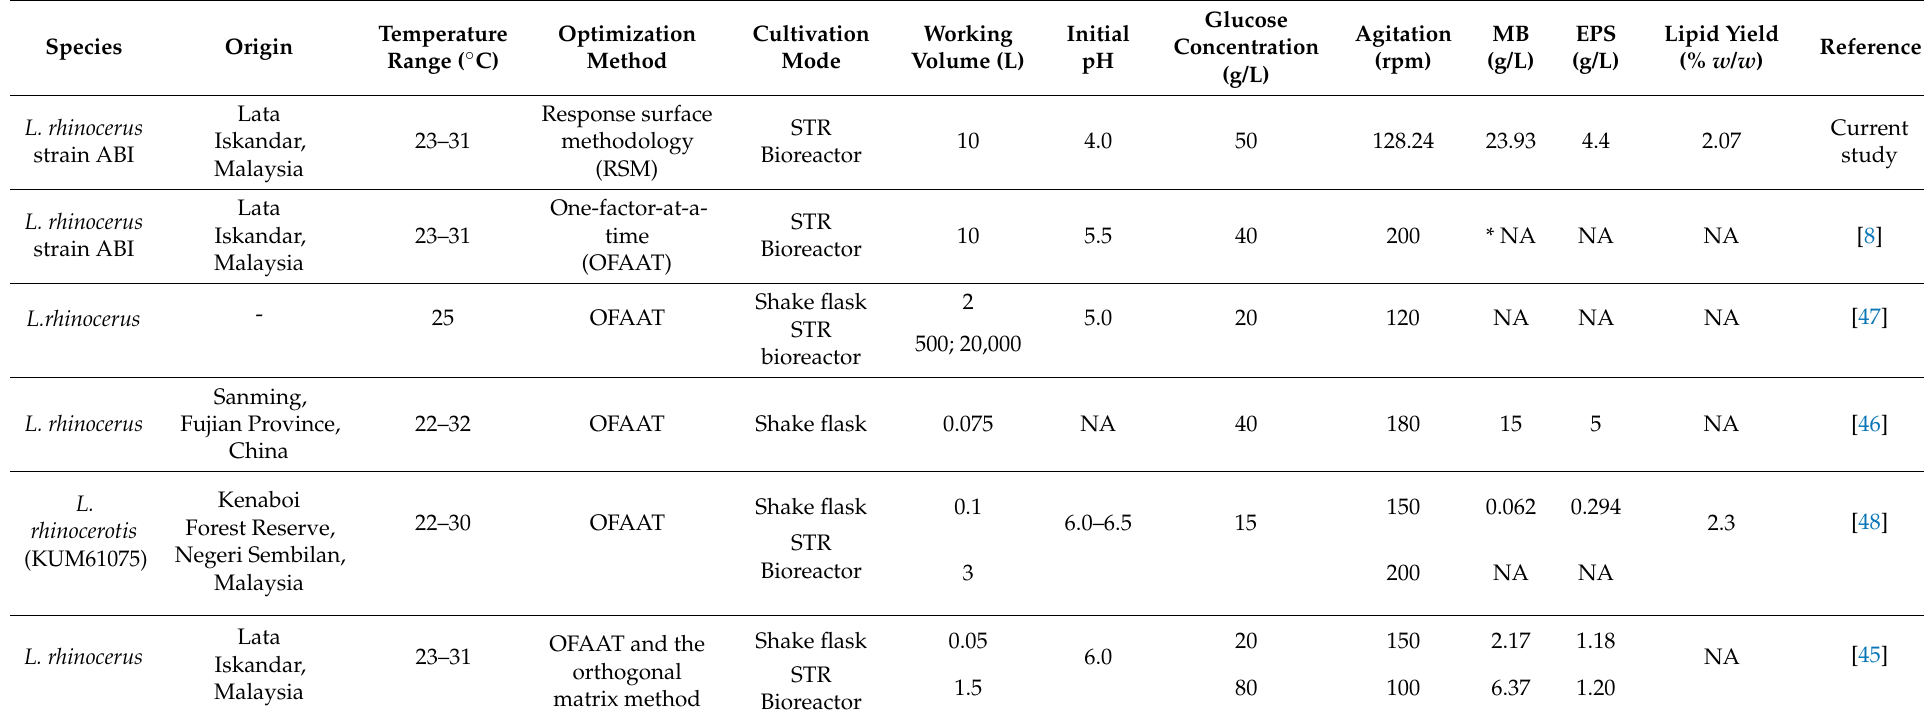
Table 7. The literature comparison for the optimization of L. rhinocerus using submerged liquid